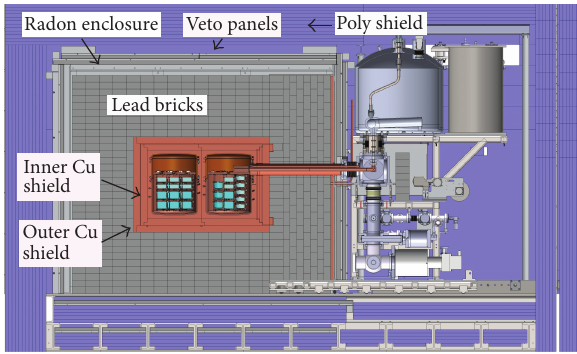
Figure 9: The shield system in cross section, shown with both cryostats installed.